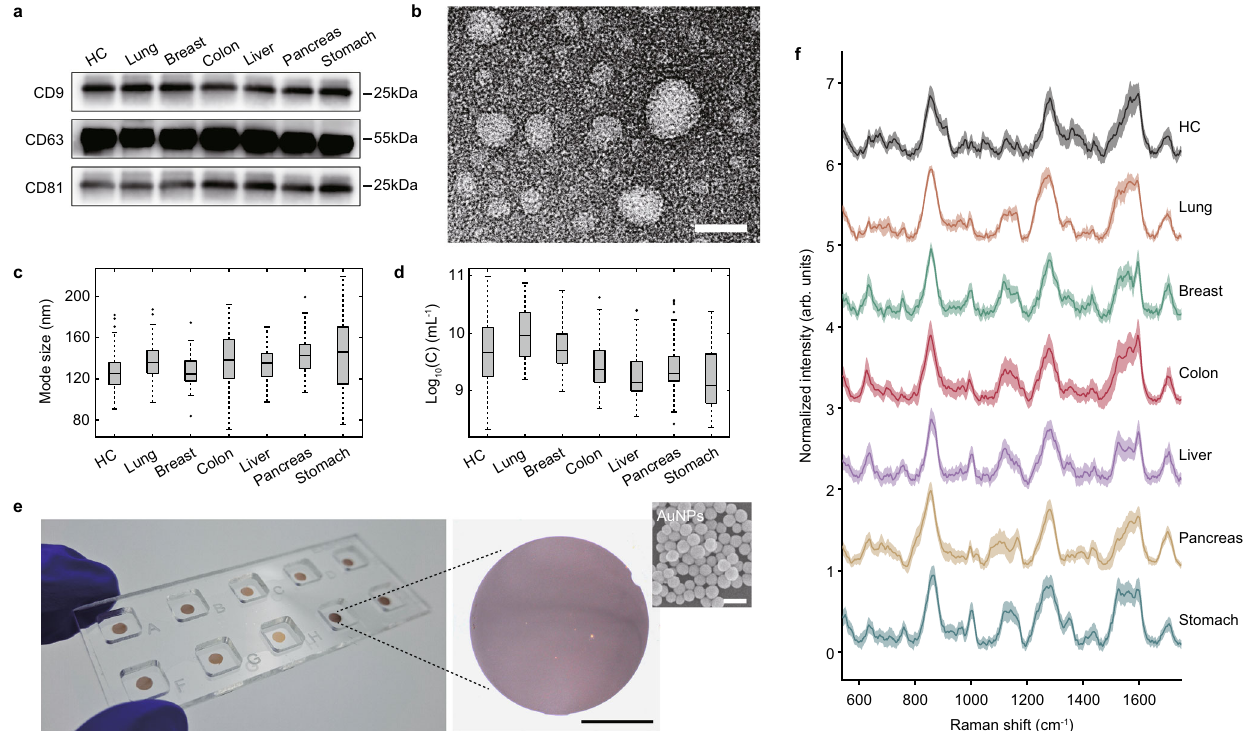
Fig. 2 | Exosome isolation and detection. a – d Evaluation of isolated exosomes. a Western blot showing exosome marker expression. b Cryo-TEM image to show themorphologyofisolatedvesicles.Scalebar,50nm. c , d NTAshowing c modesize and d particle concentration. The number of measured samples was 150, 100, 60, 60, 29, 60, and 30, respectively. The central line, box, errorbar, and dots indicate